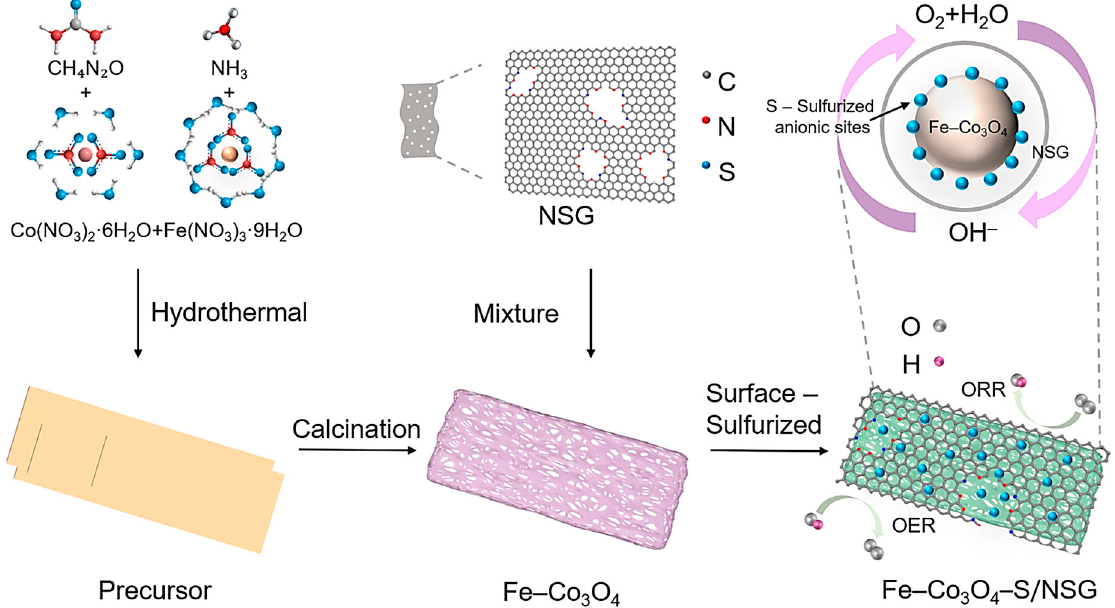
Figure 6. Schematic synthesis route of Fe–Co 3 O 4 –S/NSG as an OER/ORR bifunctional electrocata-